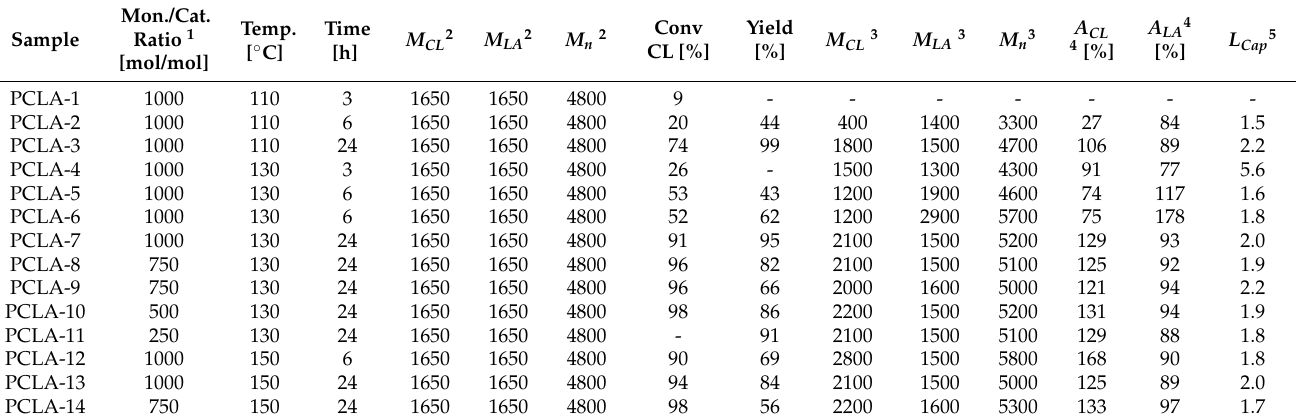
Table 1. The optimization of the PCLA synthesis conditions.